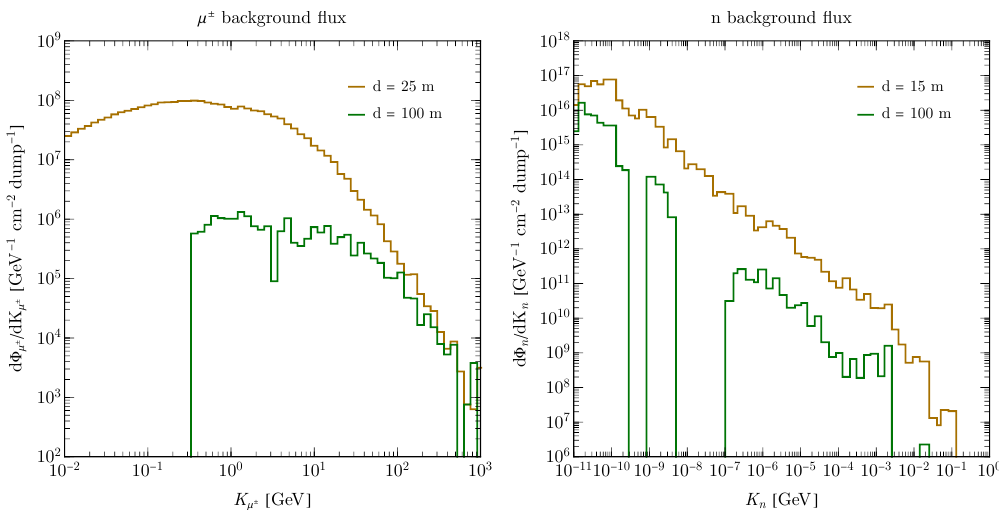
Figure 13. Left: kinetic energy spectrum of muons at distances of 25 m (orange) and 100 m (green) from the beam dump. Right: kinetic energy spectrum of neutrons at distances of 15 m (orange) and 100 m (green) from the beam dump.